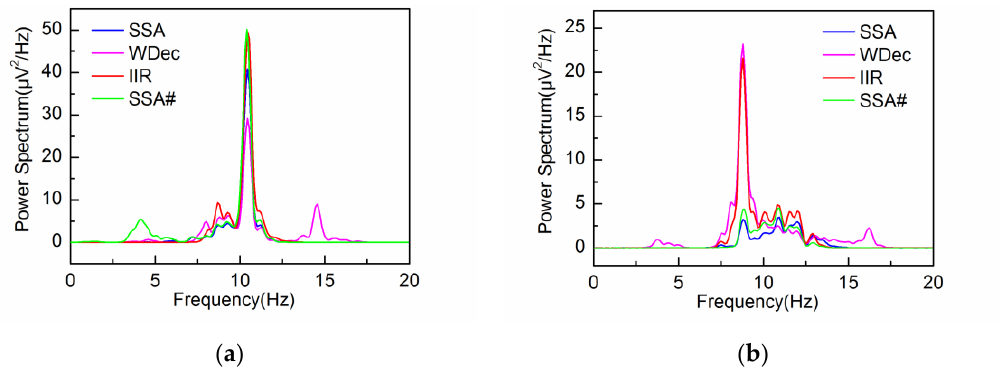
Figure 16. PSD of the extracted alpha rhythm by four methods: ( a ) under eyes-closed condition; ( b ) under eyes-open condition.